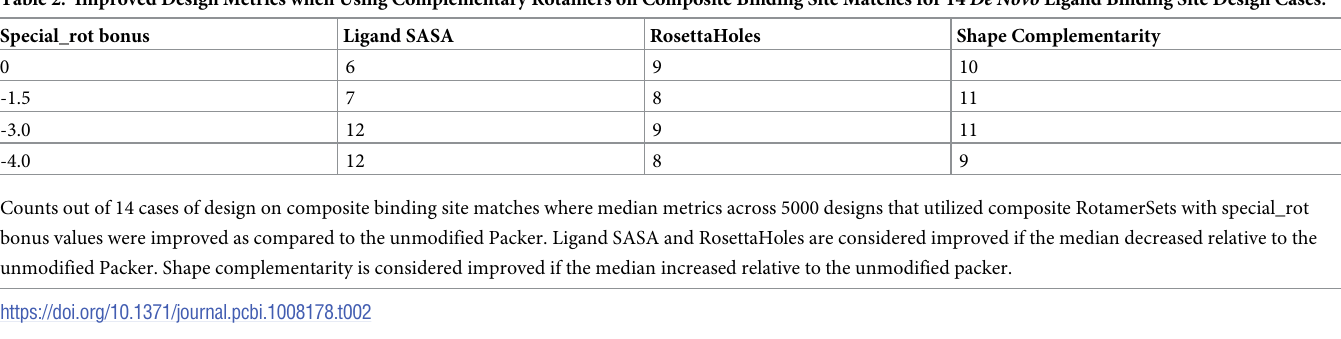
Table 2. Improved Design Metrics when Using Complementary Rotamers on Composite Binding Site Matches for 14 De Novo Ligand Binding Site Design Cases.